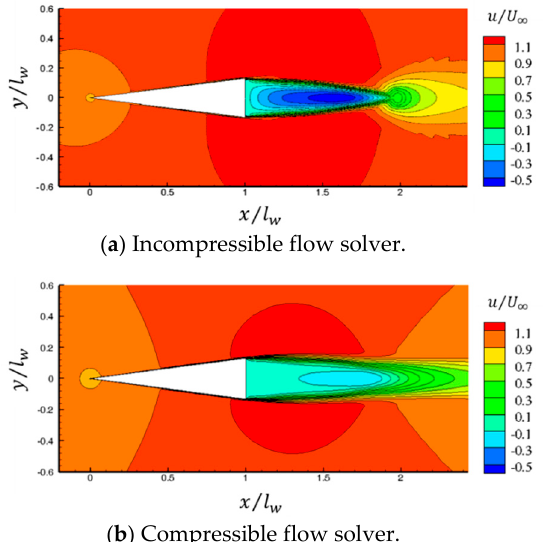
Figure 9. Non-dimensionalized x-velocity contours around wedge at σ = 0.4.